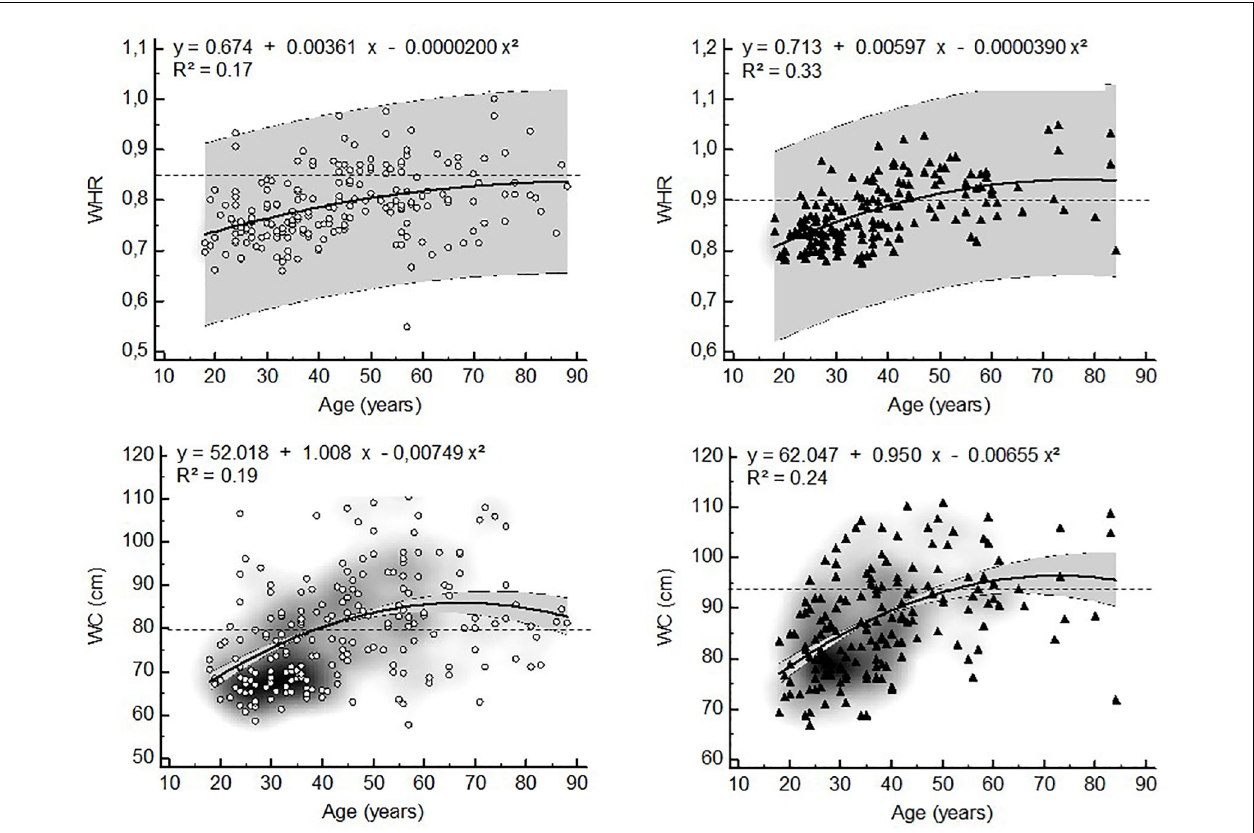
FIGURE 2 | Non-linear relationships between anthropometric estimates of visceral adiposity and age ( (cid:78) = women, (cid:78) = men, WHR = waist-to-hip ratio, WC = waist circumference, dashed lines represent WHO (25) cut points for increased cardiometabolic risk in whites, gray zone represents 95% confidence